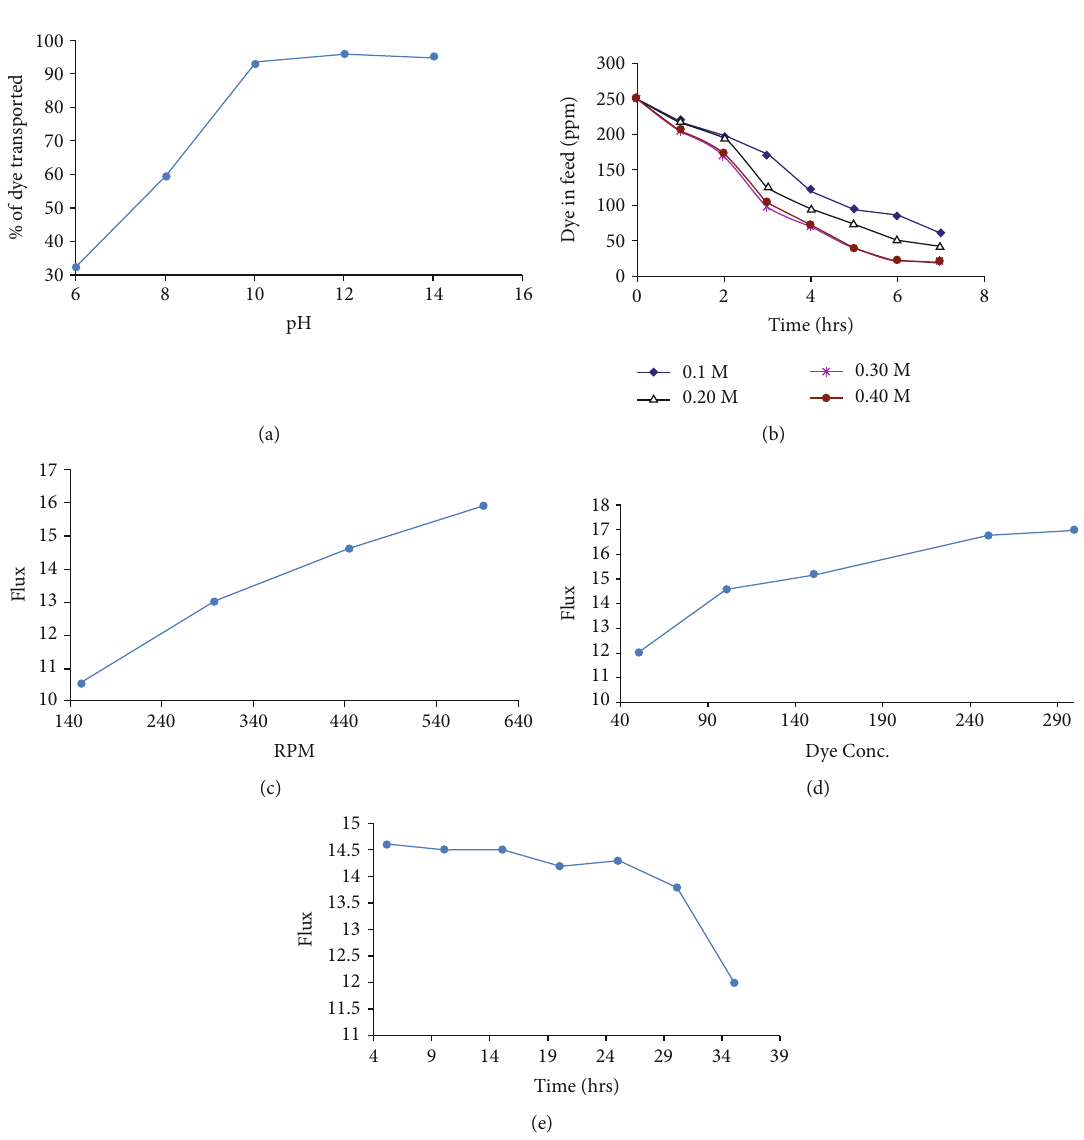
Figure 2: (a) In fl uence of pH on dye transport, (b) in fl uence of acid molarity in the strip side, (c) variation of fl ux with the stirring speeds, (d) fl ux variation with dye concentration in feed solution, and (e) aging study: decline in fl ux with prolonged